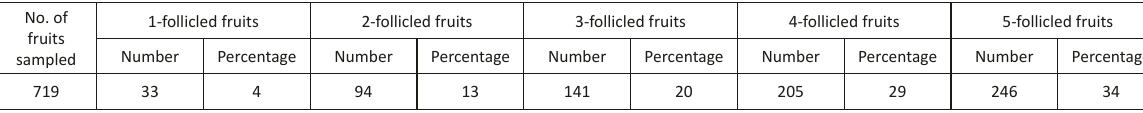
Table 3. Fruiting rate in Hildegardia populifolia